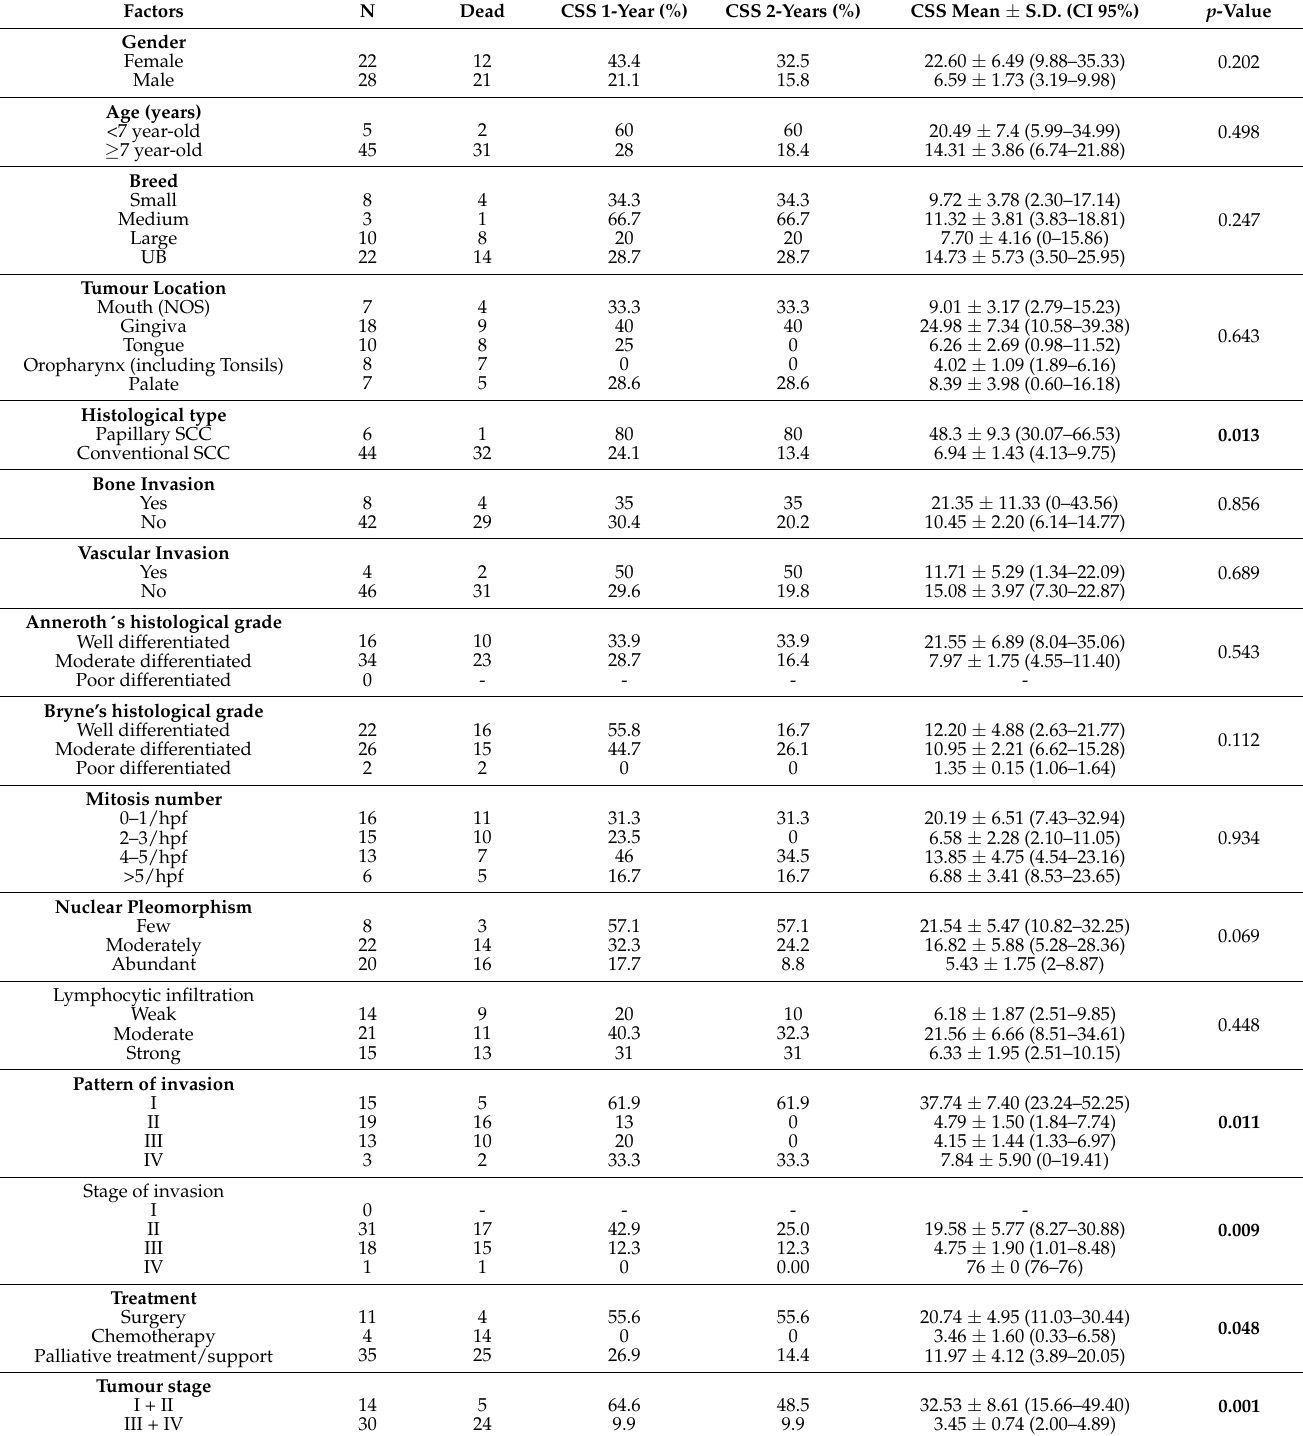
Table 4. Univariate analysis of cancer-specific survival (CSS) according to clinical and histopathologi- cal